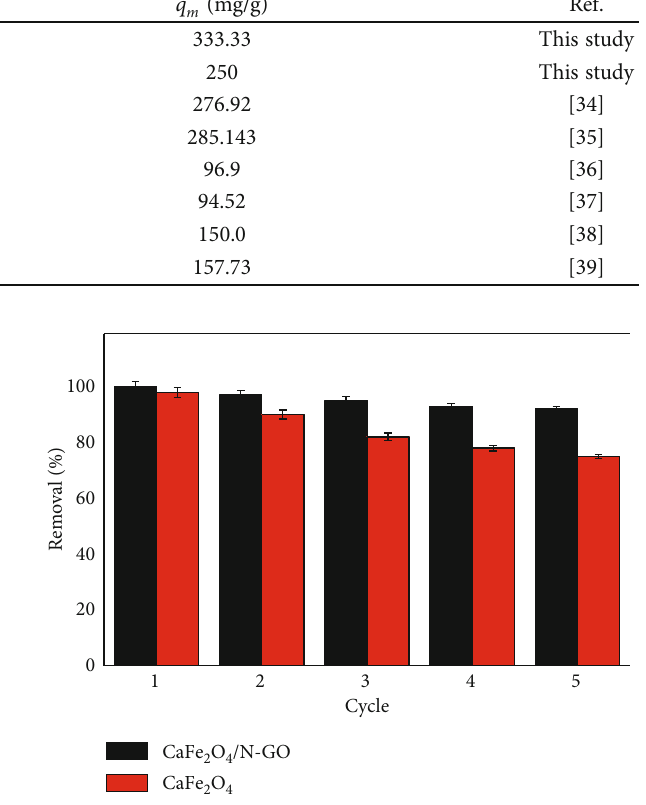
Figure 10: Reusability study of the synthesized CaFe